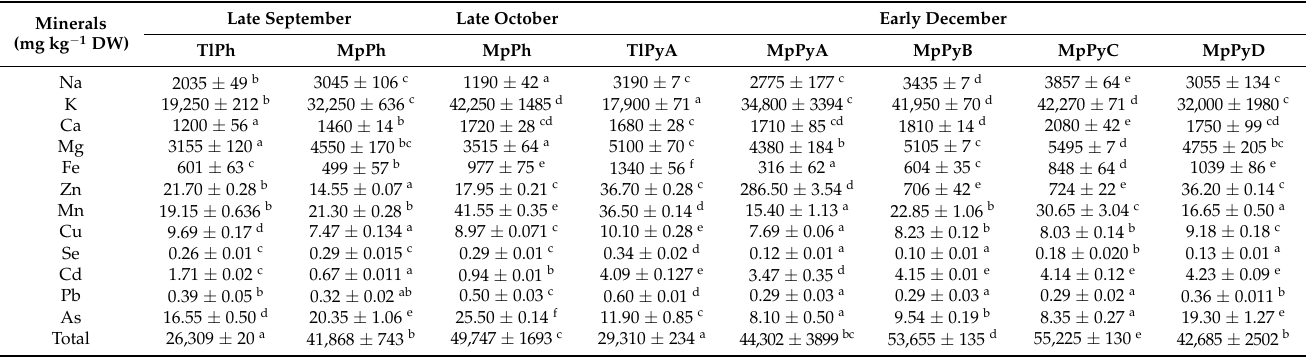
Table 2. The content of minerals in the N. haitanensis and N. yezoensis samples ( n = 3). The different letters (a/b/c/d/e/f) in each row shows that the values are significantly different ( p < 0.05). The abbreviations were the same in Table